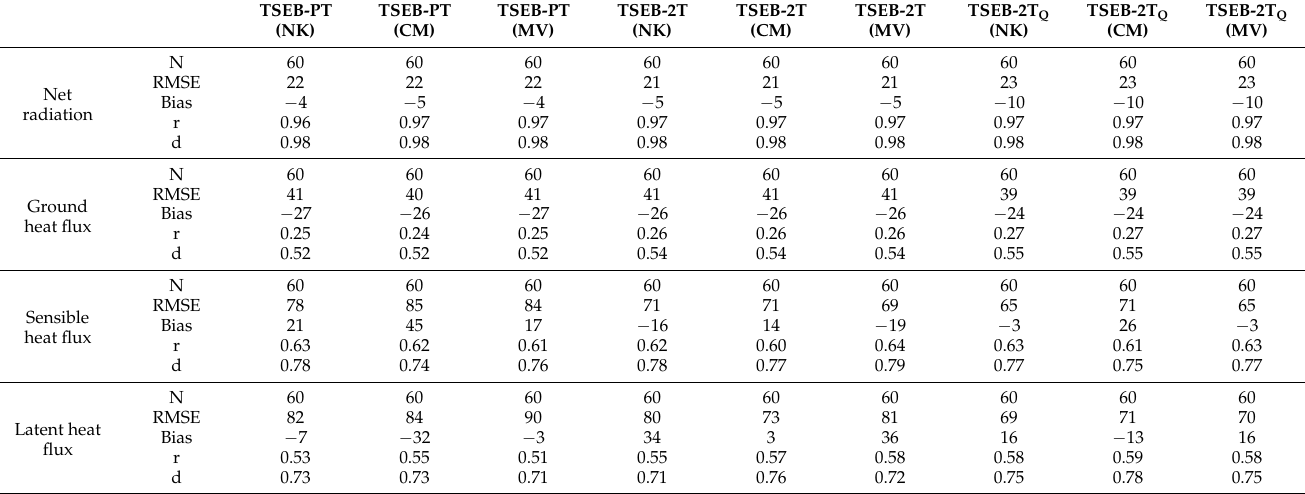
Table 1. Statistics of the goodness of fit showing the performance of each TSEB modeling result within the footprint area. N is the number of cases used for validation, RMSE is the root mean square error (Wm − 2 ), Bias is the mean bias computed as the measured minus the modeled (Wm − 2 ), r is the Pearson correlation coefficient between the measured and modeled, and d is the Willmott’s index of agreement [51]. When N is different in different groups, d is still calculated but not a representative metric to compare the model performance.